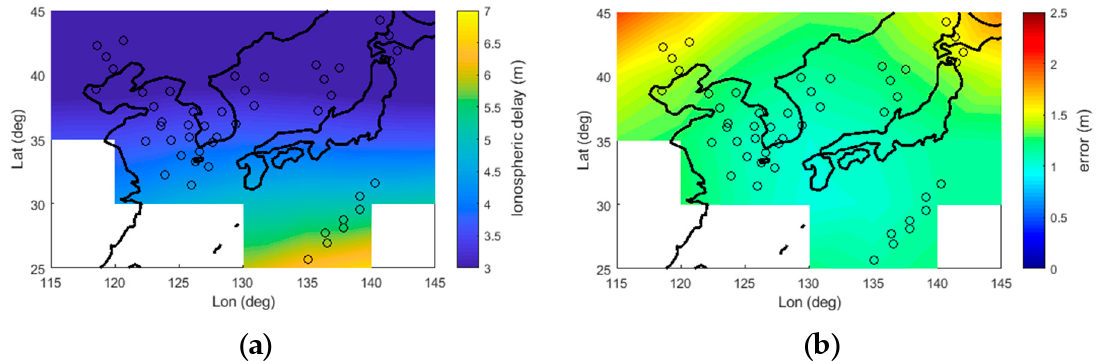
Figure 6. ( a ) Estimated ionospheric map and ( b ) its error in the case using only the pseudorange.